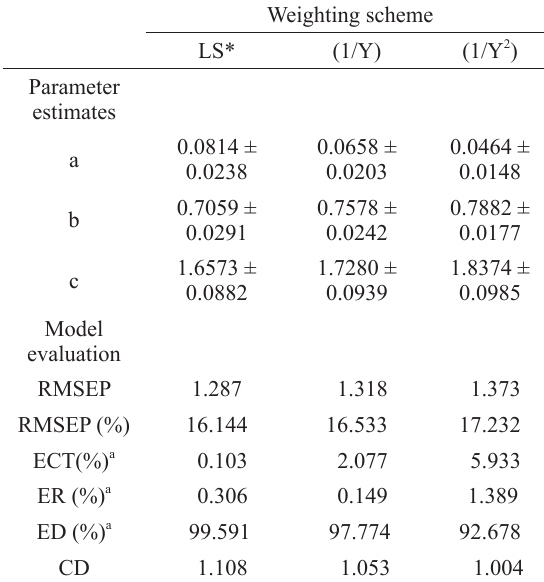
Parameter estimates ± S.E. and evaluation of three models as function of body (weight schemes) to predict pacu’s HE f mass and water temperatures.